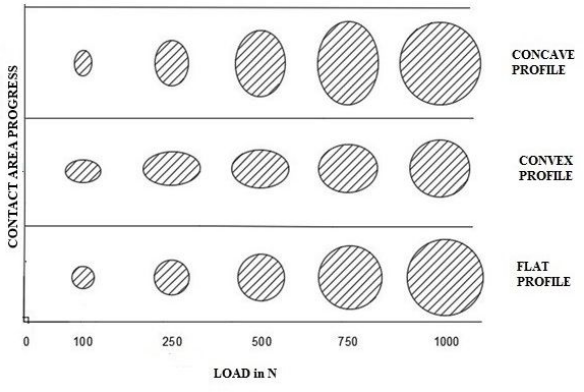
Figure 7: Contact area progress of hemispherical fingertip on vari- ous profiles Table 3: Conversion Factor (X) Geometry Conversion Factor X of Fingertip Hemispherical